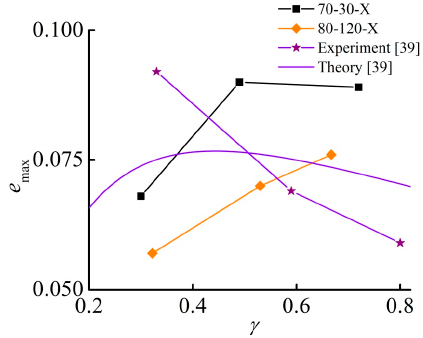
Figure 4. Comparison of experimental and theoretical results obtained in [39] with similar experimental observations in the present work.